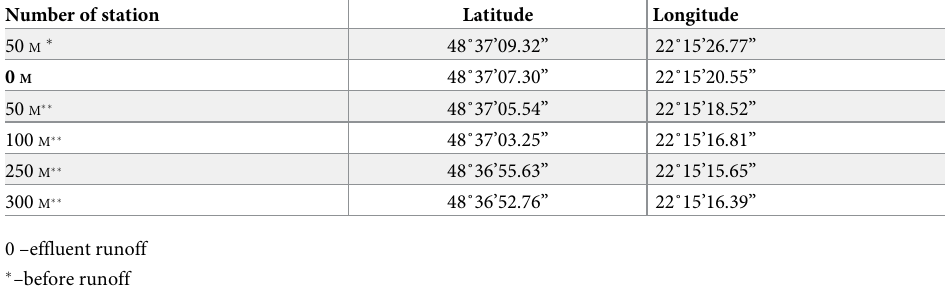
Table 1. Sampling station coordinates on the river Uhz in the area of